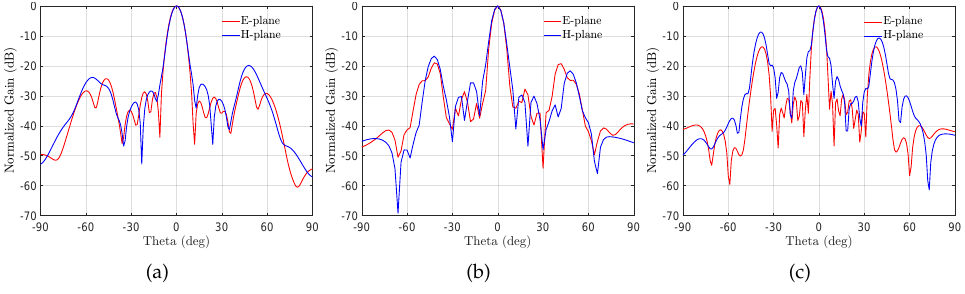
Figure 10. Normalized radiation patterns in the E -plane and H -plane at ( a ) 17.9GHz, ( b ) 20GHz, and ( c ) 22.3GHz,